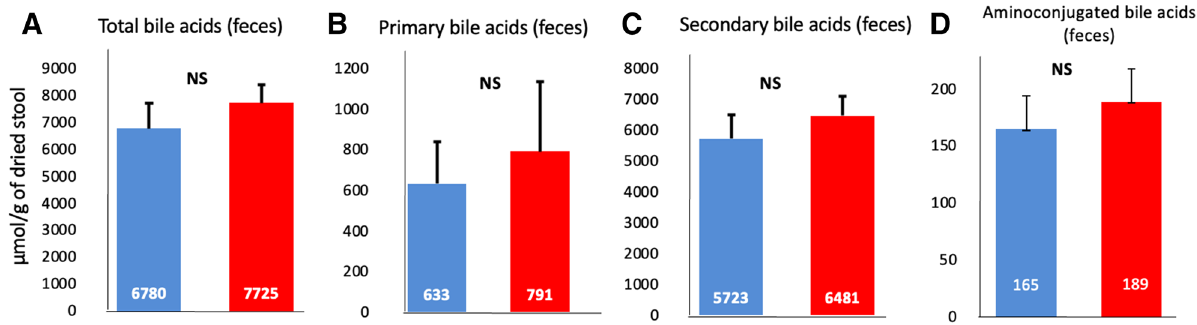
Figure 3. Comparison of bile acids concentrations in feces in non-coronary artery disease (blue bars) and coronary artery disease (red bars) patients. Concentrations (µmol/g of dried stools) of total ( A ), primary ( B ), secondary ( C ) and amino-conjugated ( D ) bile acids in feces. P < 0.05; ** P < 0.01; *** P < 0.001. Image credit : Graphpad 6.0, https:// www. graph pad. com/ scien tific- softw are/ prism/.